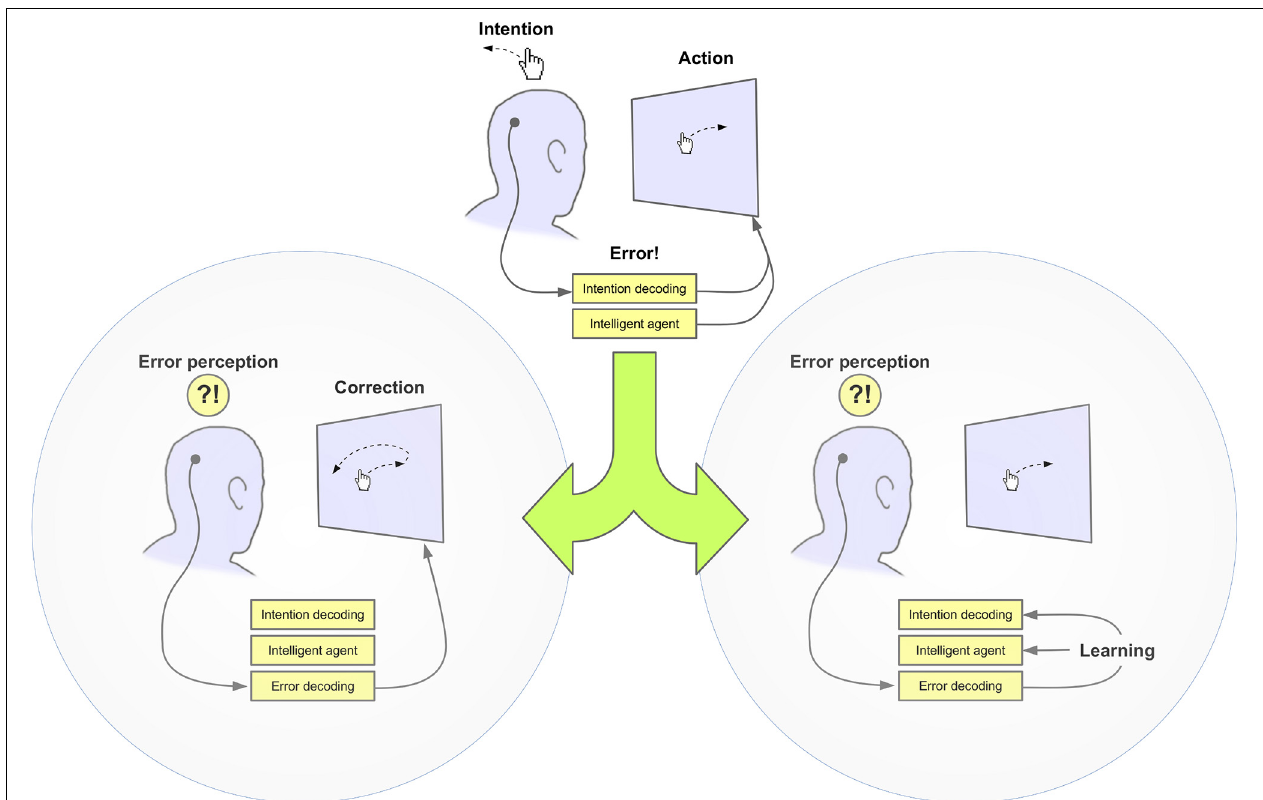
FIGURE 1 | Exploitation of error-related potentials to improve BMI performance. Left: Single trial detection of these potentials, indicating erroneous actions, is used to trigger a corrective action, e.g., preventing